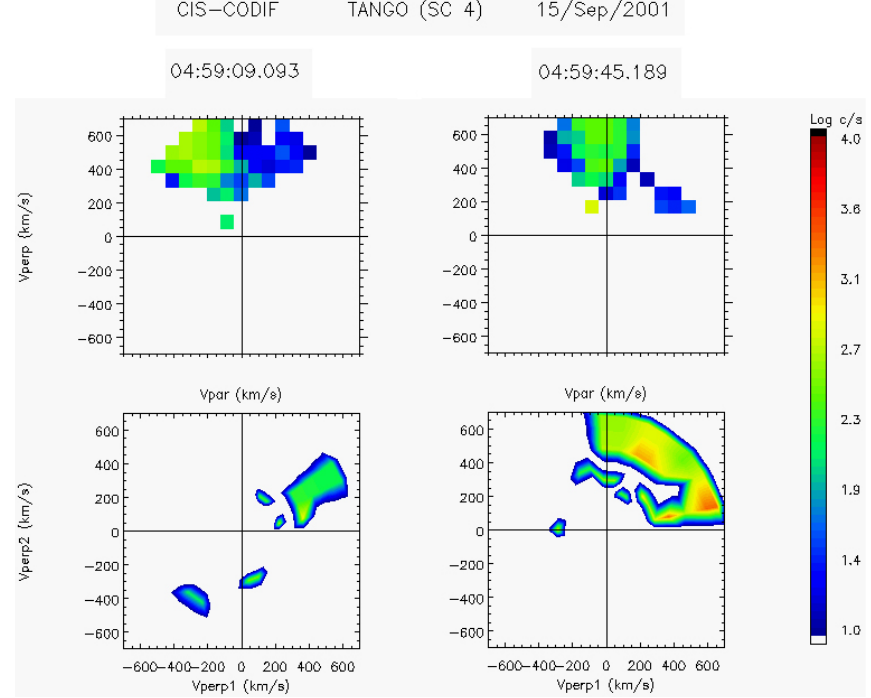
Fig. 9. Distribution functions of oxygen ions in the V || − V ⊥ coordinates from C4 in the bifurcated